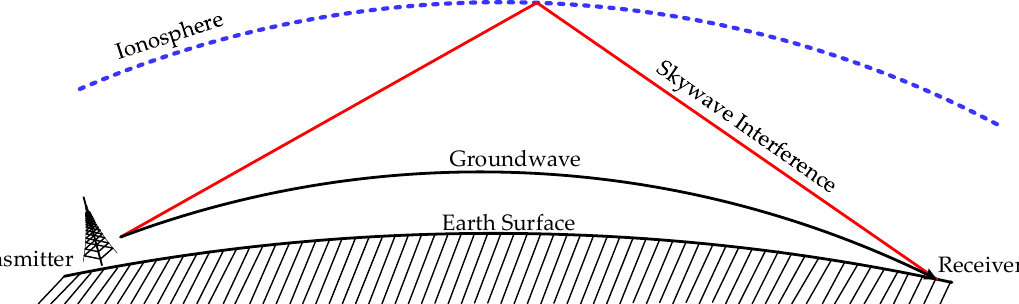
Figure 3. Schematic diagram of eLoran signal propagation channel.